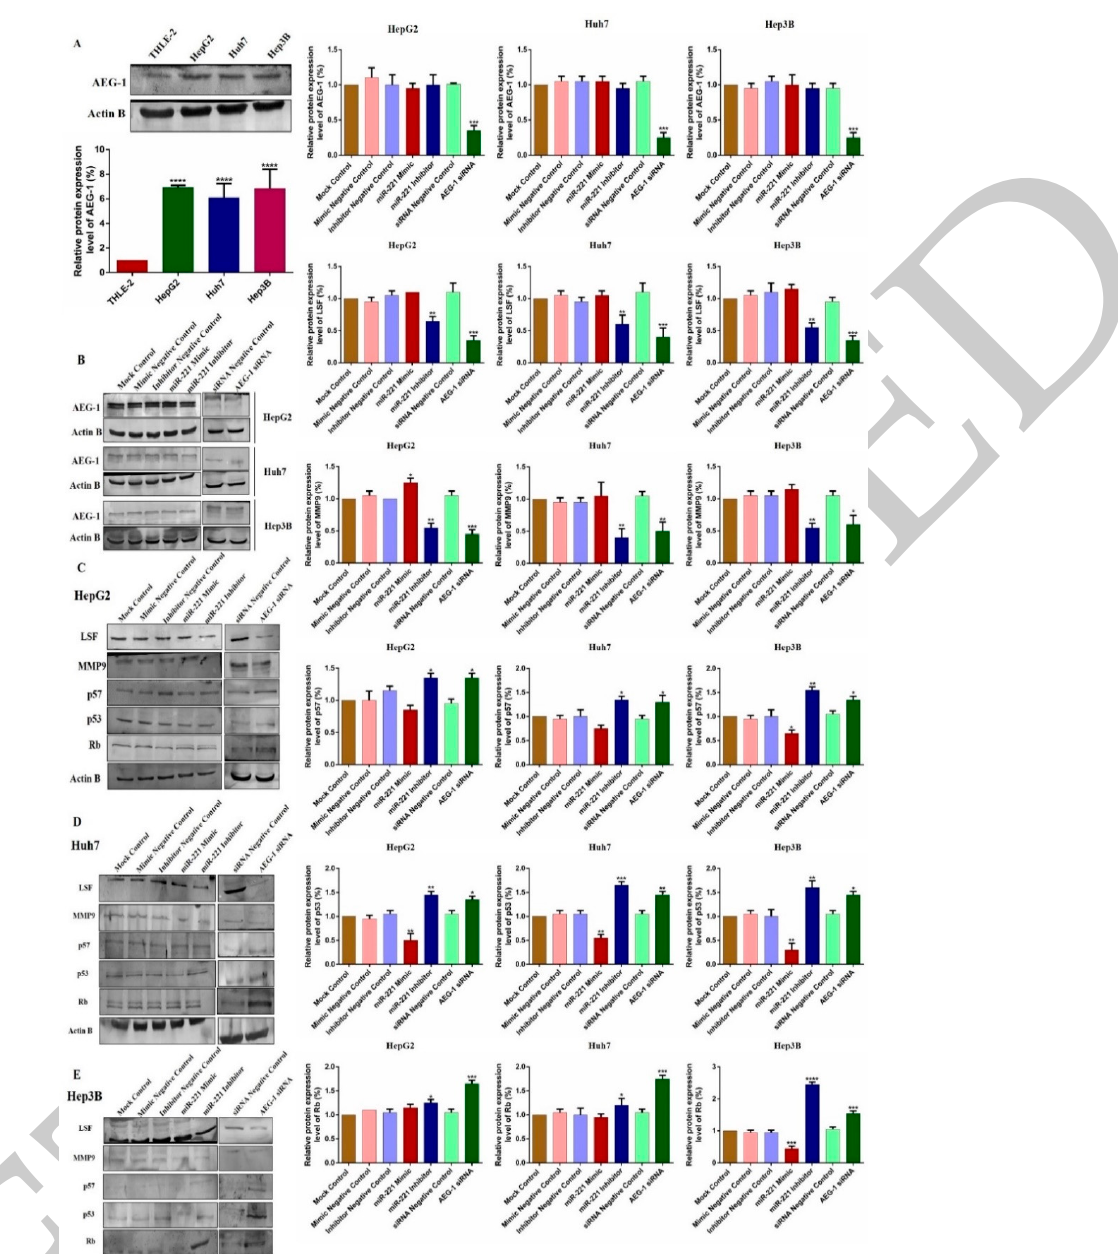
Figure 7. Knockdown of miR-221 / AEG-1 modulates cell cycle, and angiogenesis regulatory proteins in HCC cell lines. Relative protein expression of AEG-1 in HepG2, Huh7, Hep3B, and THLE-2 cells in vitro ( A ) and in miR-221 mimic, miR-221 Inhibitor, AEG-1 siRNA and their corresponding controls transfected HCC cells ( B ). AEG-1 protein expression level did not alter in miR-221 mimic, miR-221 inhibitor, and their corresponding control transfected HCC cells, and decreased in AEG-1 siRNA transfected HCC cells when compared to their controls. miR-221 and AEG-1 regulatory protein expressions in miR-221 mimic, miR-221 Inhibitor, AEG-1 siRNA and their corresponding controls transfected HCC cells analyzed by Western blot with β -actin used as the internal control. Inhibition of miR-221 and AEG-1 significantly downregulates the expression of LSF, and MMP 9 and significantly upregulates the expression of p57, p53, and RB protein levels in HepG2 ( C ), Huh 7 ( D ), and Hep3B ( E ) cells in vitro. Error bars are presented as the mean ± s.d. and p -values are presented as * p < 0.05, ** p < 0.01, *** p < 0.001, **** p < 0.0001. ns: non-significant compared to the control